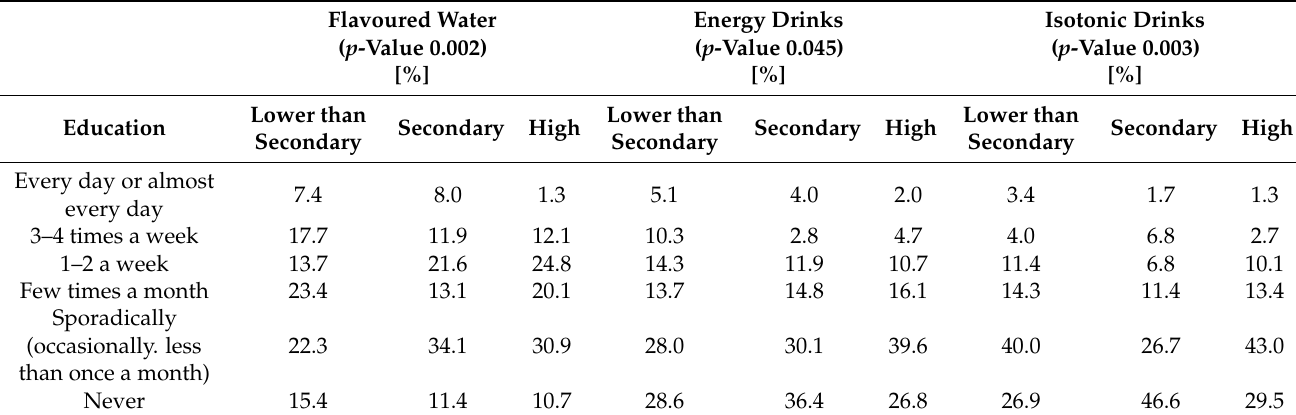
Table 2. Consumption of beverages with confirmed statistical significance taking into account the educational structure n = 500.